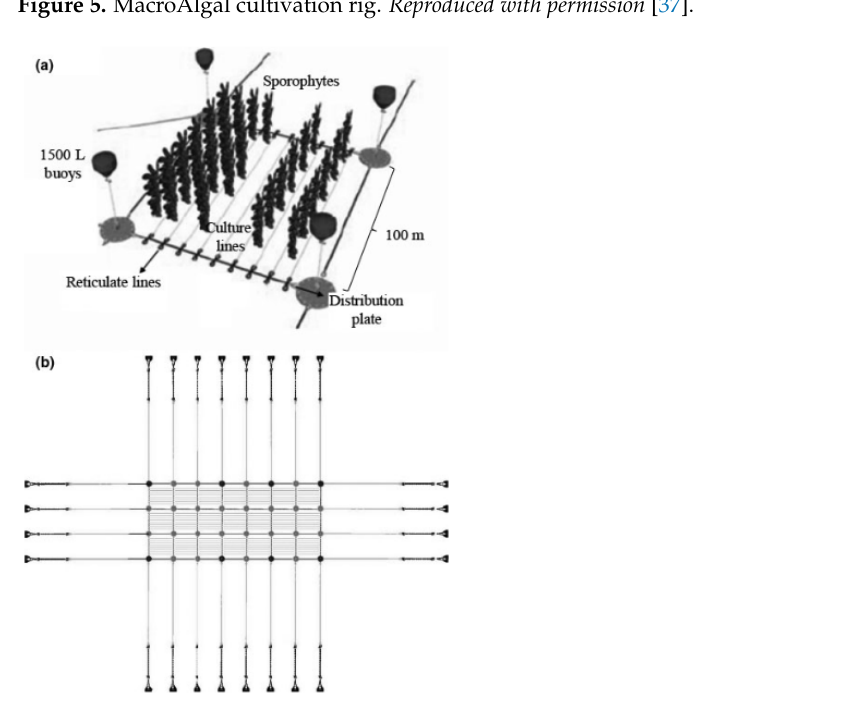
Figure 5. MacroAlgal cultivation rig. Reproduced with permission [37].